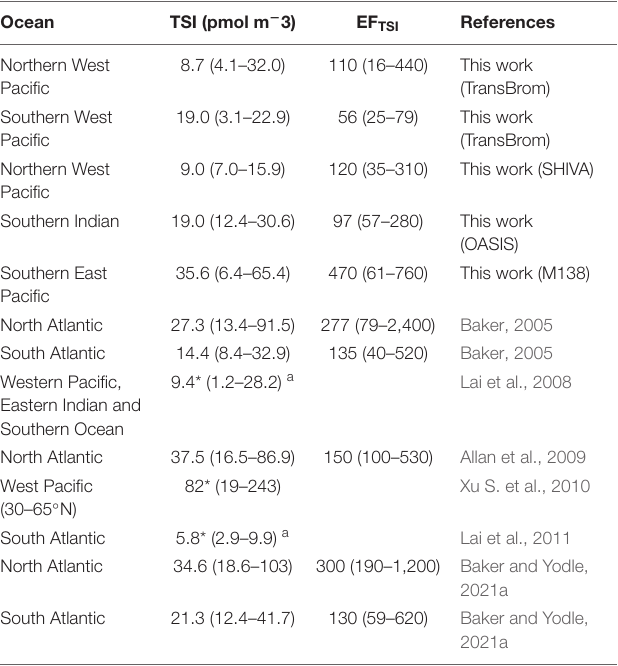
TABLE 6 | Reported total soluble iodine (TSI) concentrations and enrichment factors of TSI with respect to sea spray in bulk/total aerosols collected over the